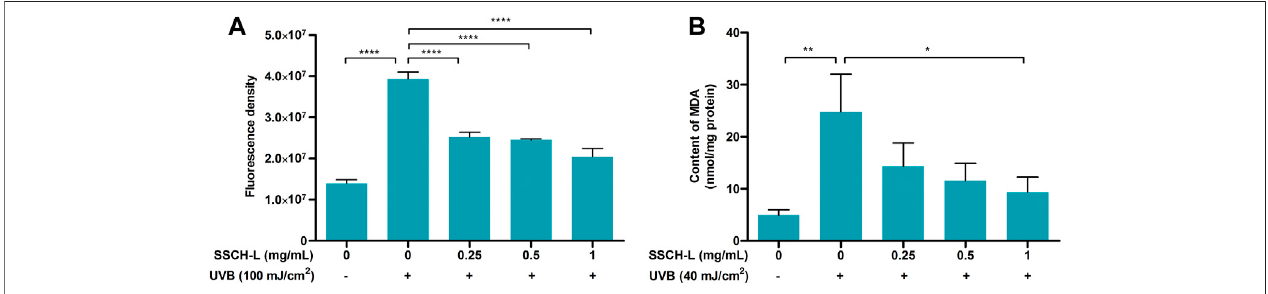
FIGURE 5 | Effect of SSCH-L on intracellular reactive oxygen species (ROS) generation (A) and contents of malondialdehyde (MDA) (B) after L929 exposured to UVB.